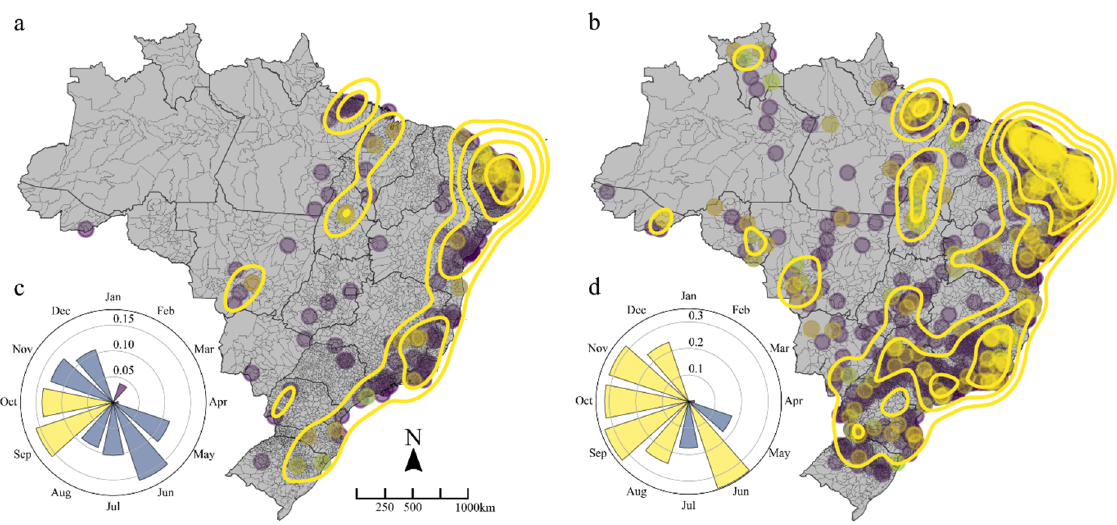
Figure 3. Municipalities consistently reporting serologically confirmed CHIKV infections ( a ), or all CHIKV notifications ( b ), every year 2017–2021 (points), overlaid with kernel density estimates weighted by the minimum annual rate of infection standardized to local municipality population. Contours were generated with bandwidth determined by Scott’s rule [17] adjusted by a factor of 0.4. Moran I estimates per calendar month show temporality of clustering for serologically confirmed ( c ) or all notification ( d ) CHIKV infections. Yellow months denote significant clustering (pseudo p value < 0.05) and blue months denote non-significant clustering ( p ≥ 0.05).